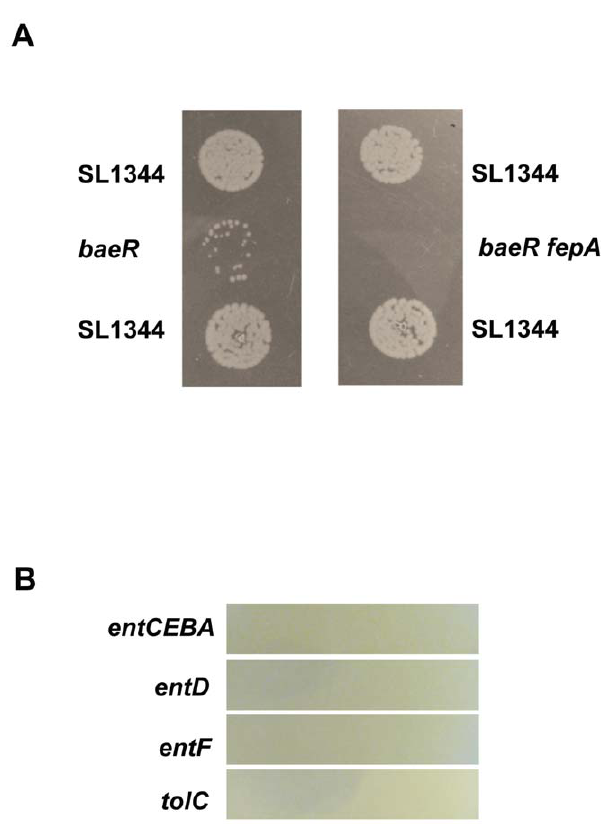
Figure 8. baeR growth on tungstate can be complemented by a secreted factor present in the wild type. Panel A: baeR isolated (bottom left of the photo) does not grow on sodium tungstate plates while the presence of the wild type strain in close proximity restore the growth (top of the photo), presumably by the secretion of siderophores rescuing the metal detoxification. A baeRfepA double mutant (right) cannot be rescued by the WT. Panel B: Salmonella deletion mutants in the genes involved in enterobactin synthesis and efflux cannot grow on LB agar plates with 30mM of sodium tungstate.